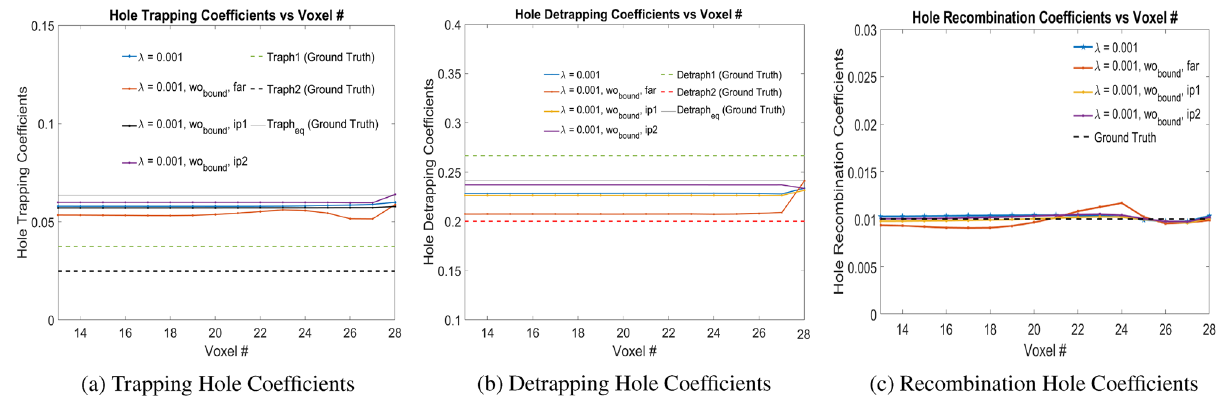
Figure 9. Trapping, Detrapping and Recombination Hole Coefficients for hole injection at Voxels 24, 26 and 28 in Physical Model-4 with (cid:31) = 0.001 as shown in the legend. Here (cid:31) refers to (cid:31) 2 in Eq. (9). Readers are suggested to enlarge the figure for closer view.